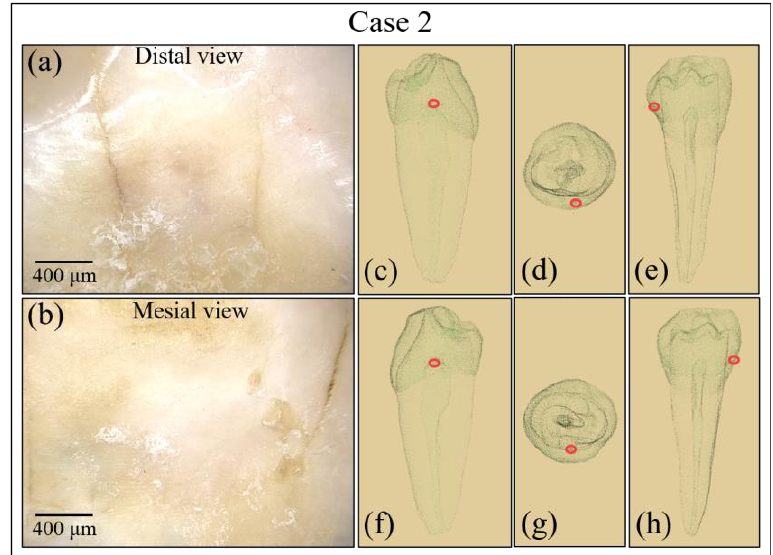
Figure 4. Optical views of the crack damage in the tooth sample of Case 2 on the distal ( a ) and mesial ( b ) sides; observation of cavities and fracture with a digital microscope from the distal. Images are at 100× magnification. ( c – e ) and mesial ( f – h ) sides.